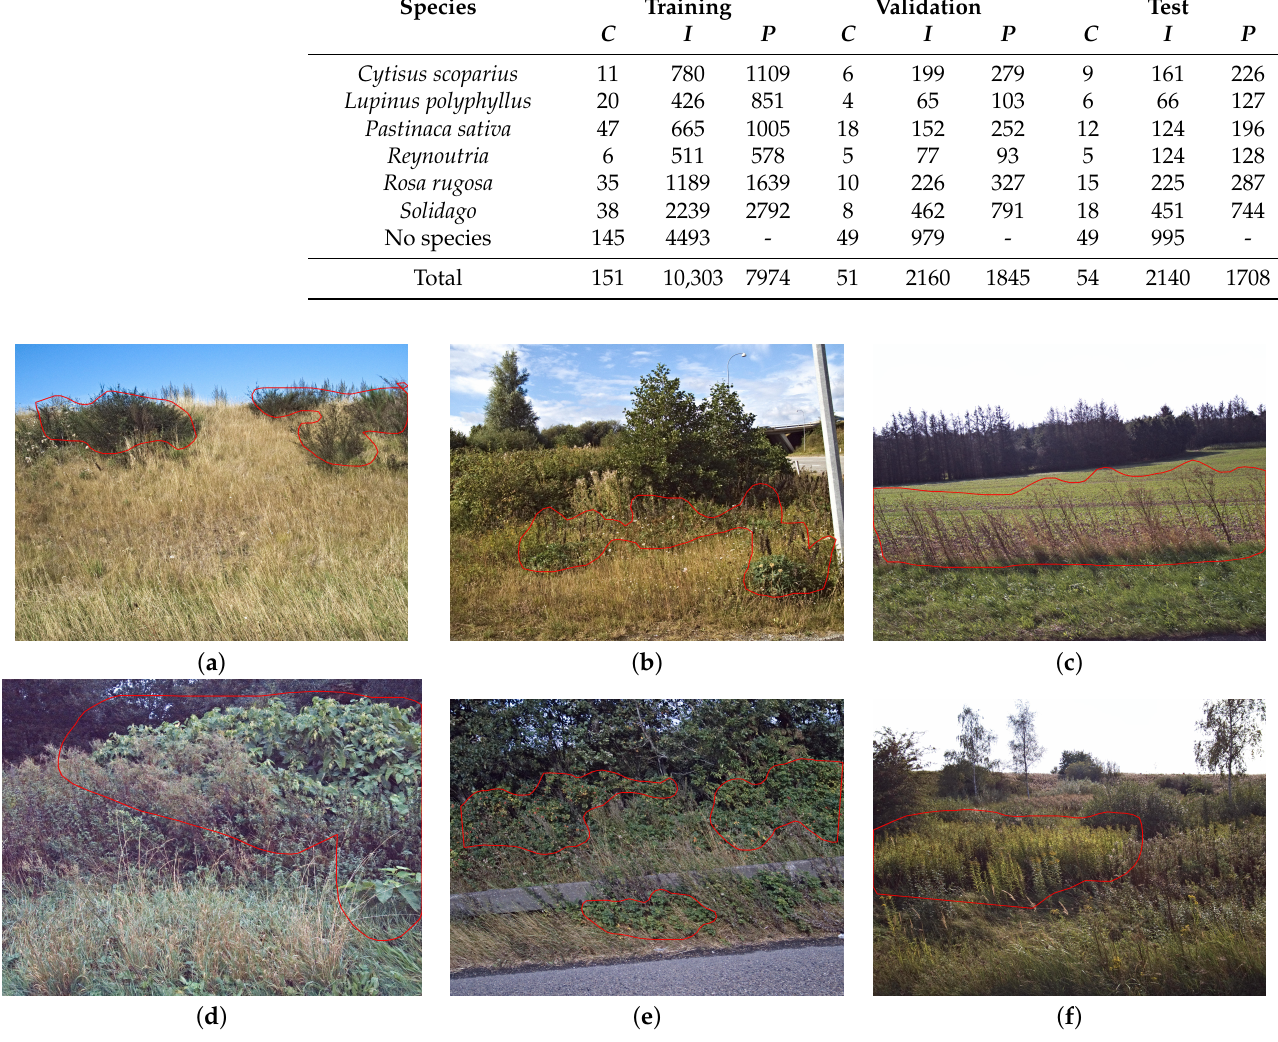
Figure 6. Examples from the training set of ( a ) Cytisus scoparius , ( b ) Lupinus polyphyllus , ( c ) Pastinaca sativa , ( d ) Reynoutria , ( e ) Rosa rugosa , and ( f ) Solidago . The annotations are shown as red